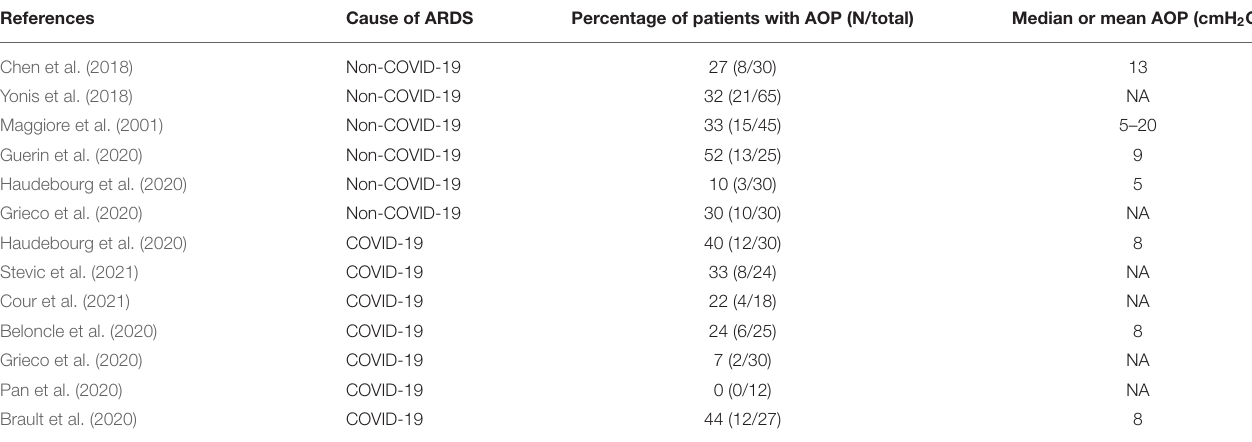
TABLE 1 | Values of airway opening pressure in non-COVID-19 or COVID-19-related acute respiratory distress